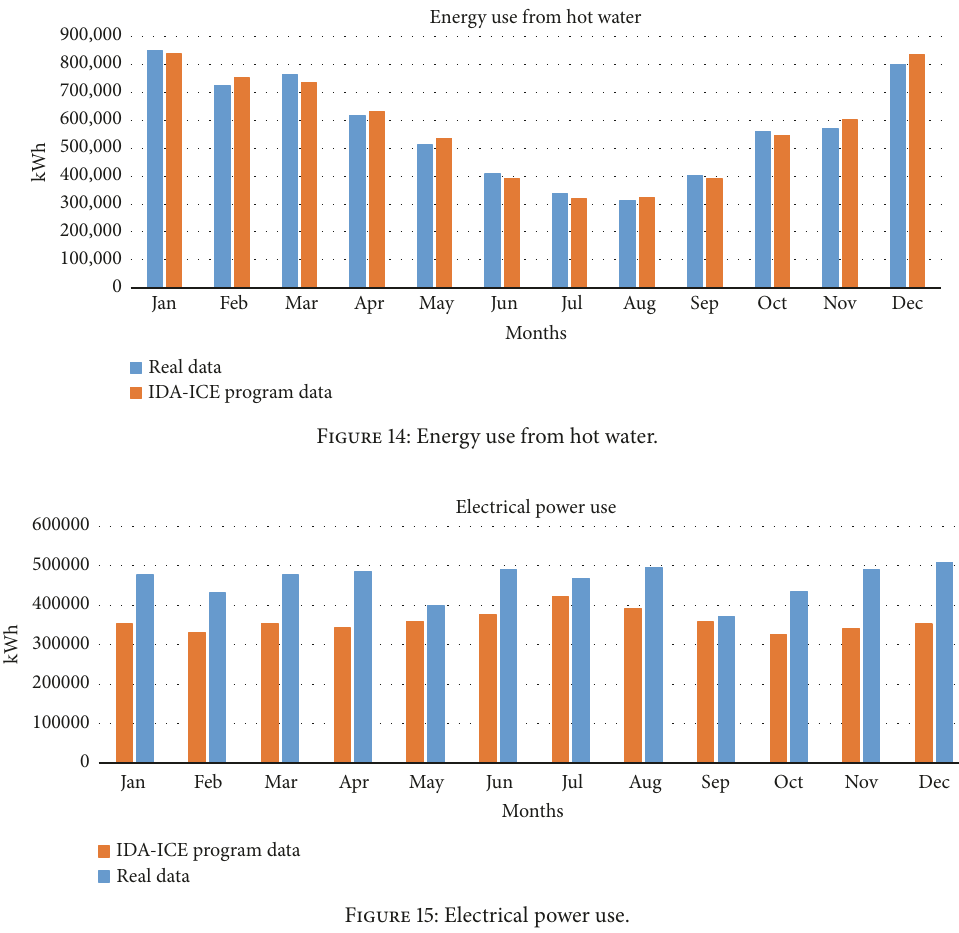
Figure 15: Electrical power